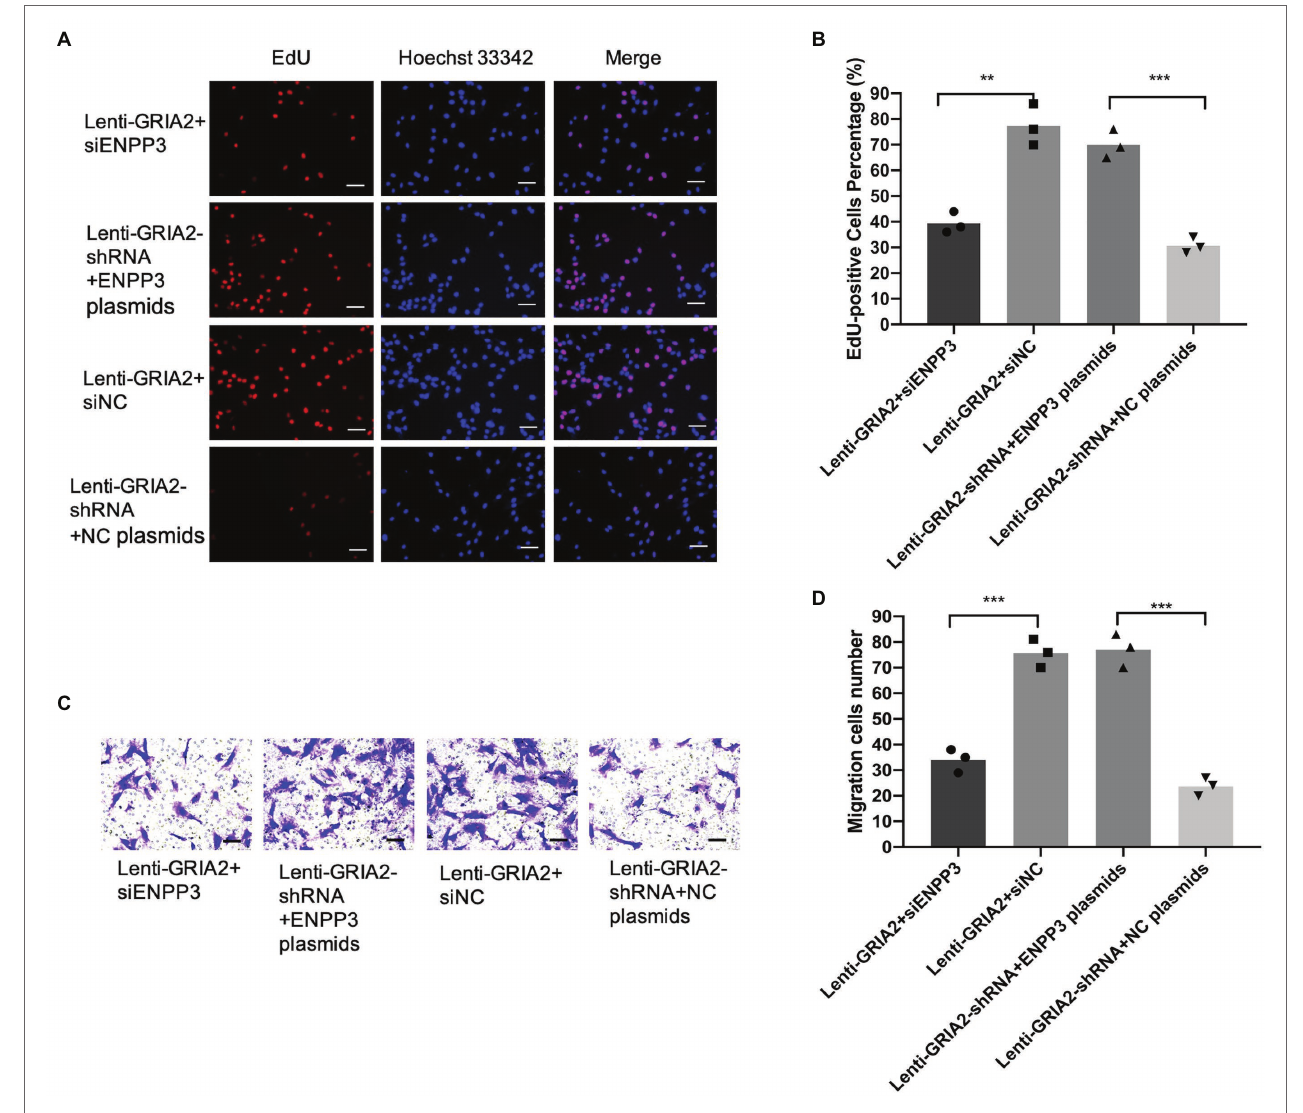
FIGURE 5 | GRIA2 interacted with ENPP3 and regulated the proliferation and migration of VSMCs. (A,B) si ENPP3 and ENPP3 plasmids and siNC and shRNA NC plasmids were transfected into GRIA2 lentivirus-transfected VSMCs. The EdU assay illustrated the proliferation of VSMCs (scale bar, 50 μ m; n = 3). (C,D) Transwell assays illustrated the migration of VSMCs (scale bar, 100 μ m; n = 3). Images are representative, and the bar graph shows the average data of four independent experiments ( n = 3). Images of EdU and Transwell migration assays were taken at 200× magnification. Data are presented as the mean ± SEM. **Statistically significant difference ( p < 0.01) and ***statistically significant difference ( p < 0.001). VSMCs: vascular smooth muscle